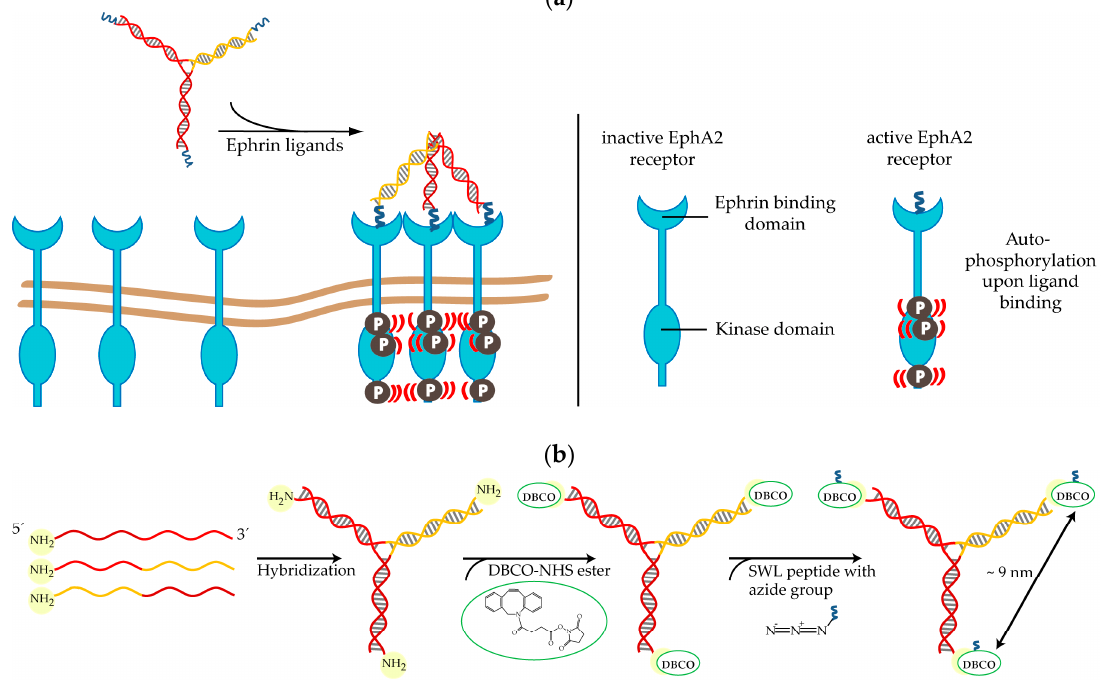
Figure 1. SWL-coupled DNA trimer and its action on EphA2 receptors: ( a ) EphA2 (light blue) cluster formation and subsequent autophosphorylation due to the presence of three peptides SWL attached to DNA trimers. Inactive Eph receptors are loosely distributed on cell membranes and become ordered when activated [50]. ( b ) Synthesis of SWL-coupled DNA trimer. Three partially complementary strands (complementary parts indicated by same color) are hybridized to form the DNA structure. Primary amine groups on 5 ′ ends react with dibenzylcyclooctyne (DBCO)-NHS esters (green) and form amid bonds. Peptides SWL with azide group on the C-terminus (dark blue) react with DBCO to form stable triazoles.